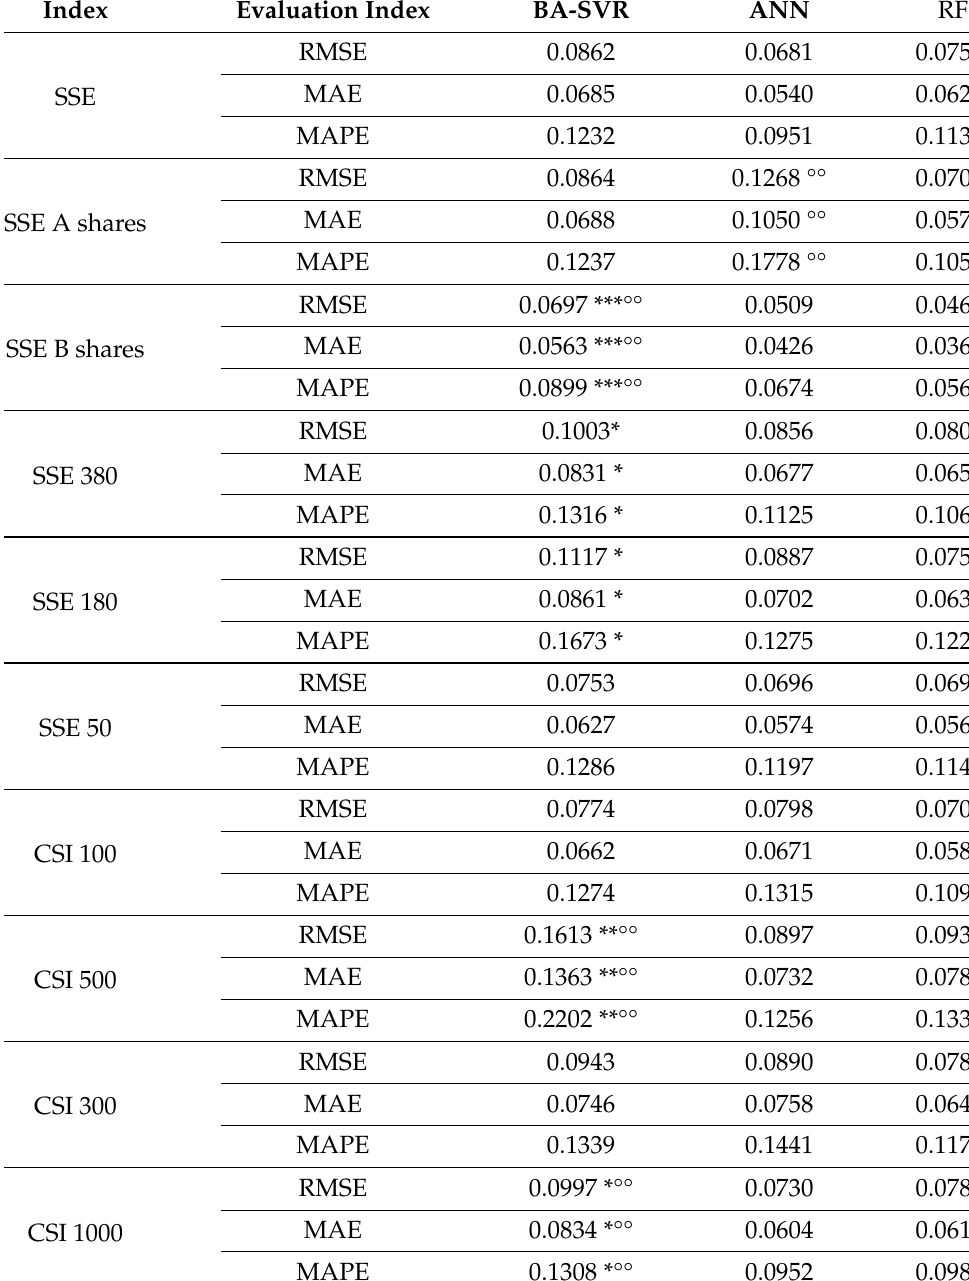
Table 15. The 20-day short-term forecast effect of 18 stock